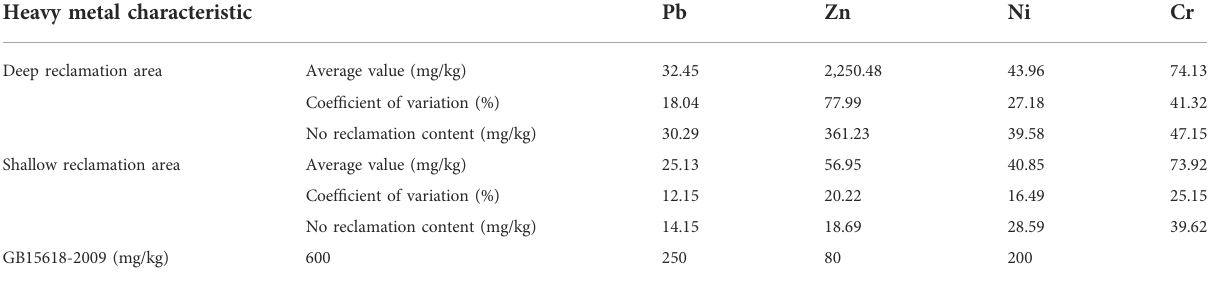
TABLE 1 Characteristics of the heavy metal content in deep and shallow reclaimed areas and unreclaimed